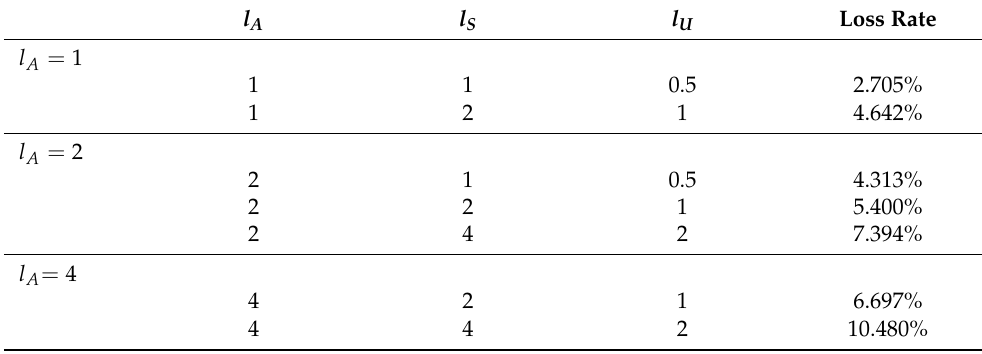
Table 13. Storage loss of the leaf layout at a certain width of the picking